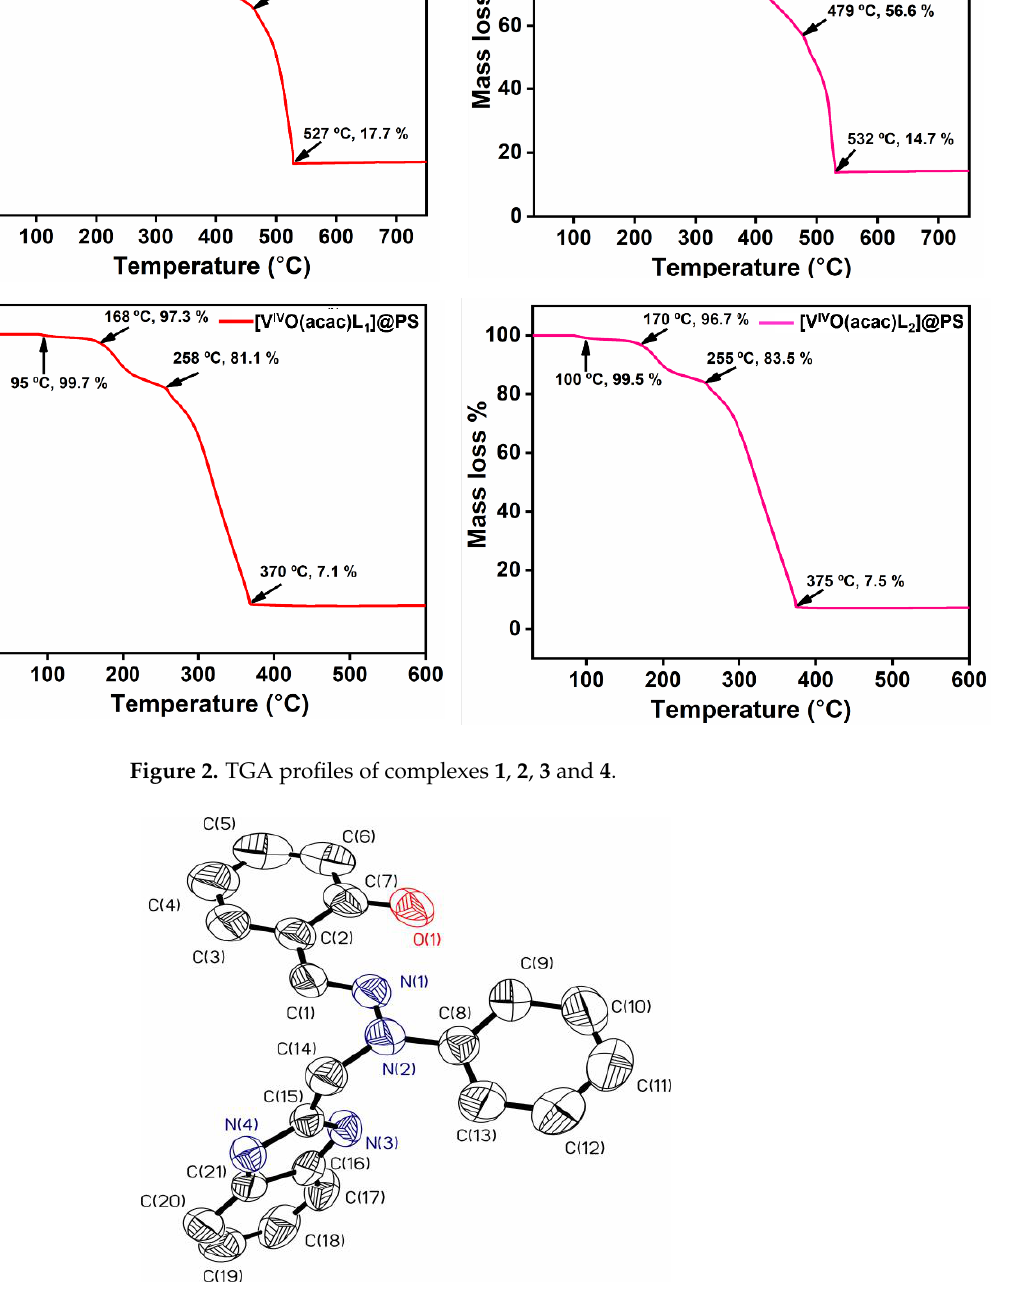
Figure 3. ORTEP of the asymmetric unit in ligand HL 1 ( I ). Non-hydrogen atoms were drawn using 50% probability ellipsoids. Hydrogen atoms were omitted for clarity. The drawing was made with the SHELXL set of programs. CCDC number: